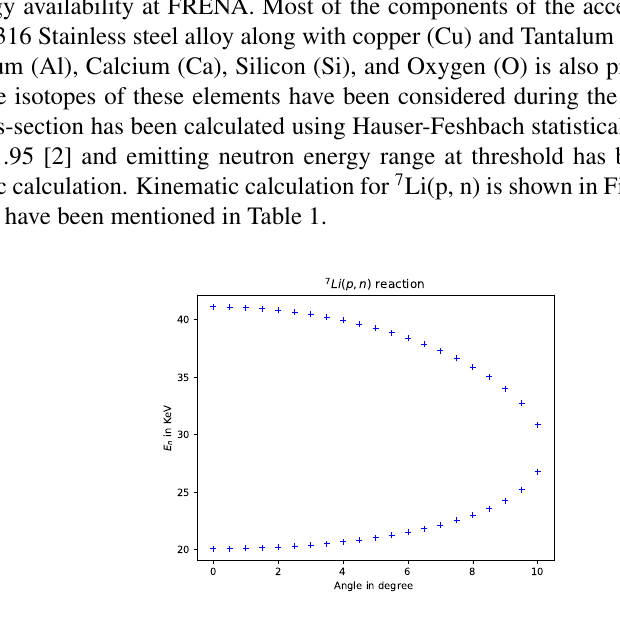
Figure 1. Neutron energy range of 7 Li(p, n) reaction at threshold energy (E p = 1.8803